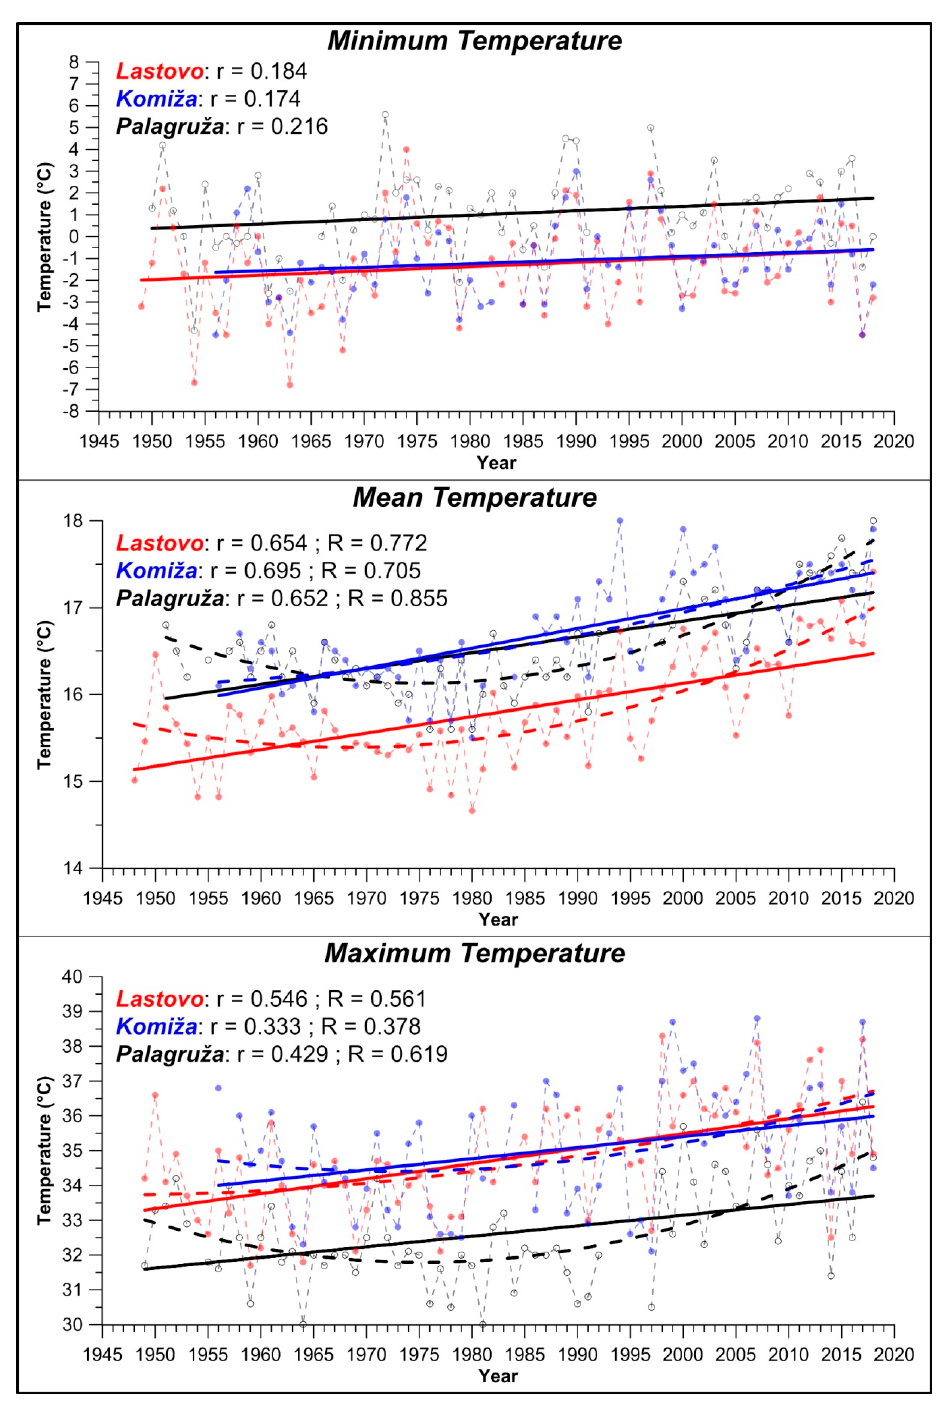
Figure 2. Time series of the minimum, mean, and maximum annual air temperature measured at the Komiža, Lastovo, and Palagruža stations. The r and R represent the correlation coefficients of the linear and quadratic regressions, respectively.